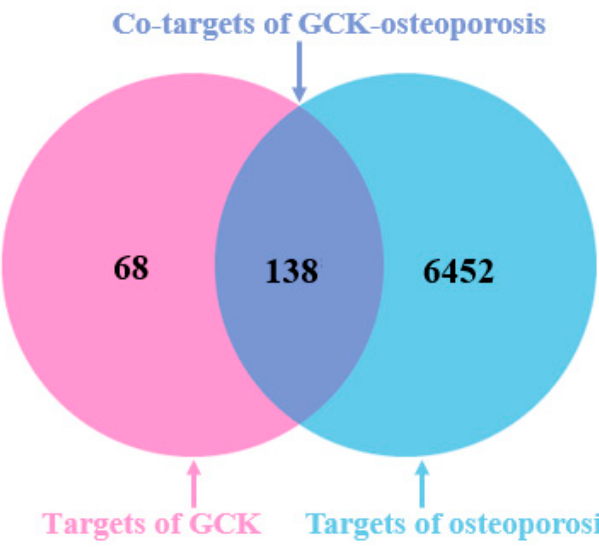
Figure 2. Co-targets of GCK–osteoporosis based on Venn diagram analysis. The red circle represents the targets of GCK, the blue circle represents the targets of osteoporosis, and the purple overlap represents the co-targets of GCK and osteoporosis.